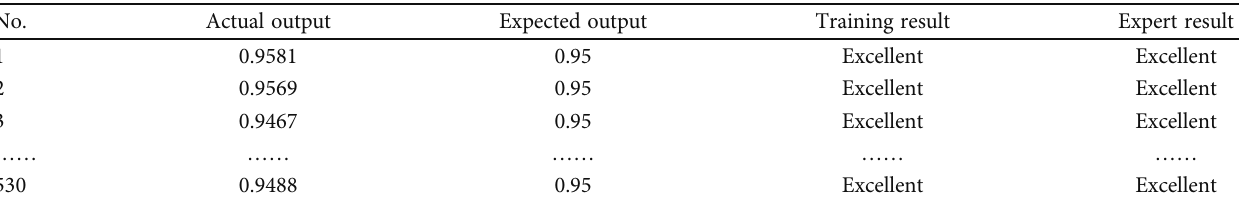
Table 13: Training results of some